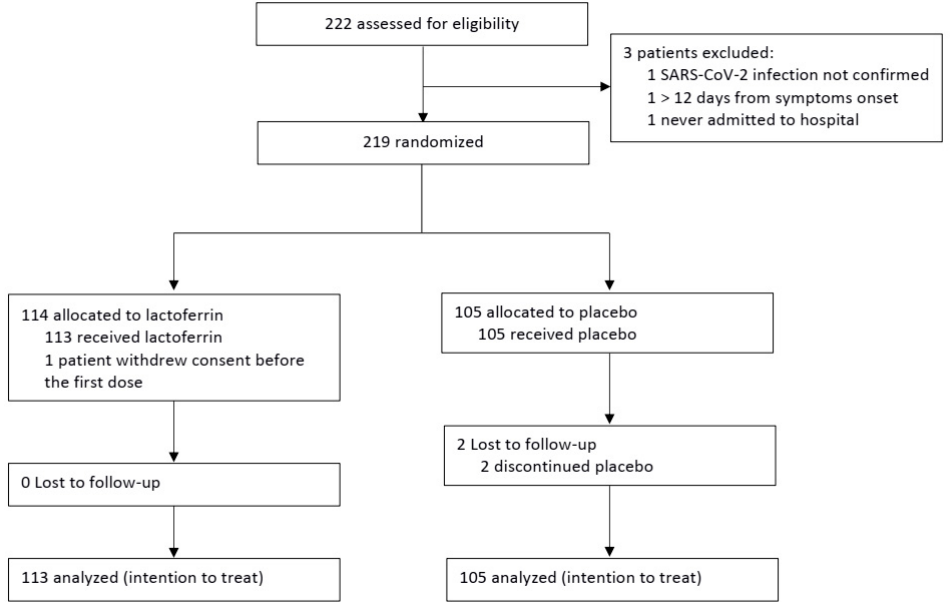
Figure 1. Flow diagram. The flow diagram shows the number of subjects assessed for eligibility, randomized, randomized and receiving intervention, randomized and withdrawing consent before treatment initiation, and included in the primary analysis. Patients who were eligible but not randomized, who were not randomly allocated, who were lost to follow-up, and who discontinued the intervention are also reported.